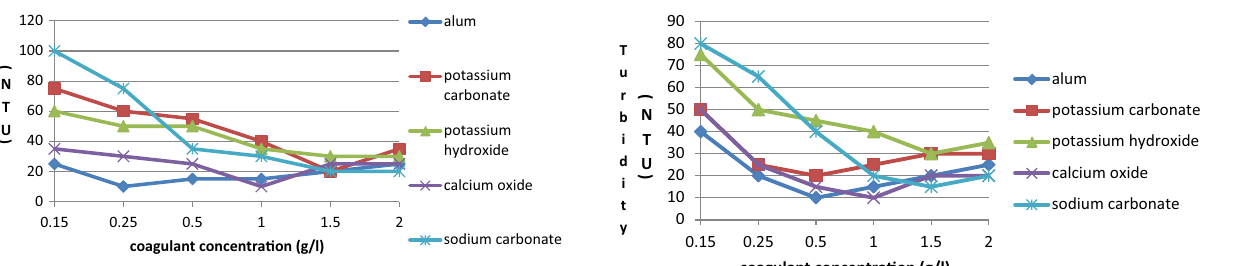
Fig. 5 Turbidity at varying doses of coagulants (pH 4)